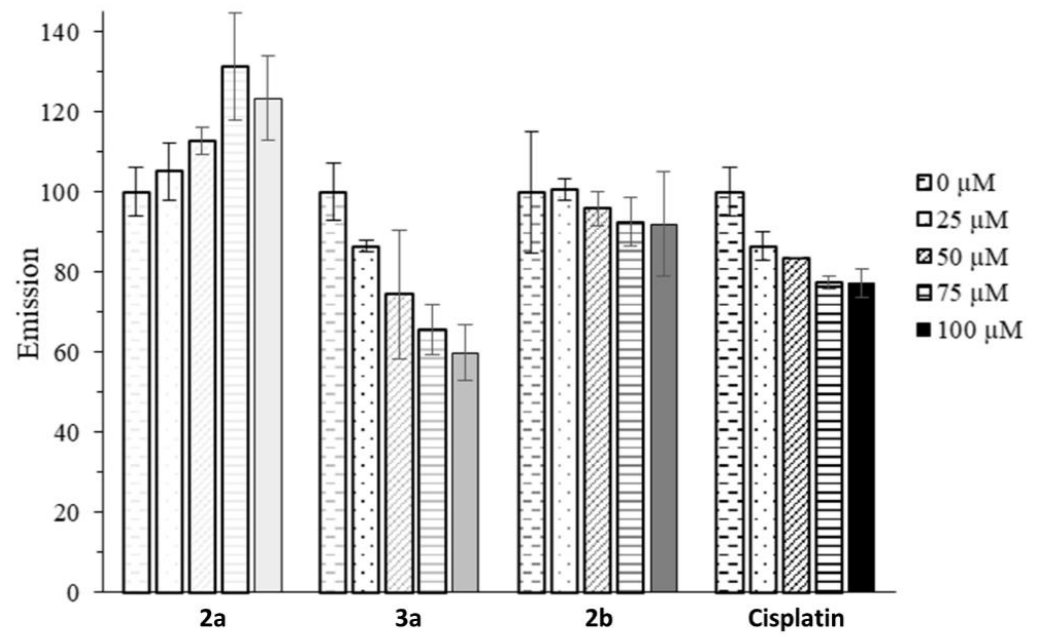
Figure 3. DNA binding of 2a , 2b and 3a using the ethidium bromide intercalation assay with salmon DNA. Cisplatin was used as positive control. n = 4 ± SD.